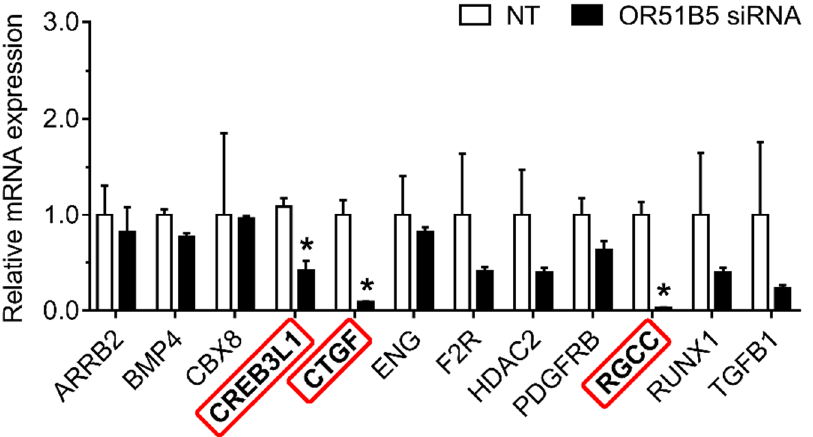
Figure 8. OR51B5 knockdown decreased collagen synthesis-related gene expression in Hs68 cells. The cells were transfected with siRNA targeting OR51B5 or non-targeting siRNA (NT) and were further incubated for 72 h. The relative mRNA levels of collagen synthesis-related genes were measured using quantitative PCR. Gene abbreviations are defined in supplementary Table S1. The results are expressed as the mean ± SEM of three independent experiments. * p < 0.05.